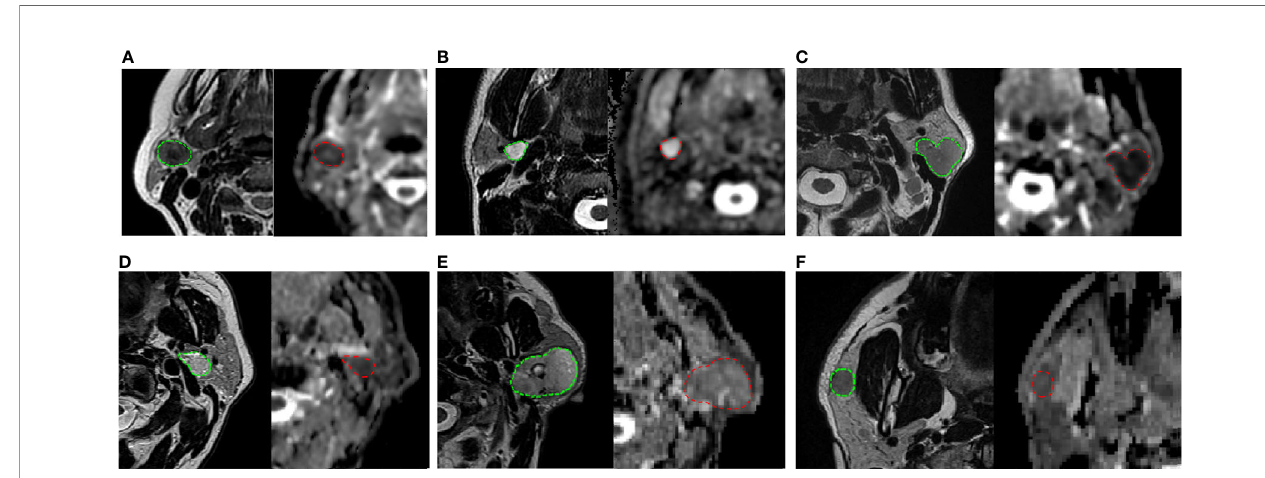
FIGURE 1 | On the top: three correctly classi fi ed lesions in the training dataset: (A) Warthin ’ s tumor with low T2 intensity, ovoidal shape and decreased ADC value (P25 of ADC = 0.834 × 10 -3 mm 2 /s), (B) pleomorphic adenoma with typical T2 hyperintensity, sharp margins and high ADC value (P25 of ADC is 1.693 × 10 -3 mm 2 /s) (C) malignant tumor with irregular margins, T2 hypointensity and low ADC value, (P25 = 0.744 × 10 -3 mm 2 /s). At the bottom: three misdiagnosed cases in the validation set: (D) Warthin ’ s tumor with high T2 hyperintensity and irregular shape (P25 of ADC = 0.930 × 10 -3 mm 2 /s); (E) pleomorphic adenoma with no typical T2 intensity and low ADC value (P25 of ADC = 1.109 × 10 -3 mm 2 /s); (F) malignant tumor with typical very low T2 intensity but regular and sharp margin and ovoidal shape (P25 of ADC = 0.836 × 10 -3 mm 2 /s). Each frame illustrates T2-weighted axial image with the user-de fi ned lesion contour on the left and the corresponding ADC map on the